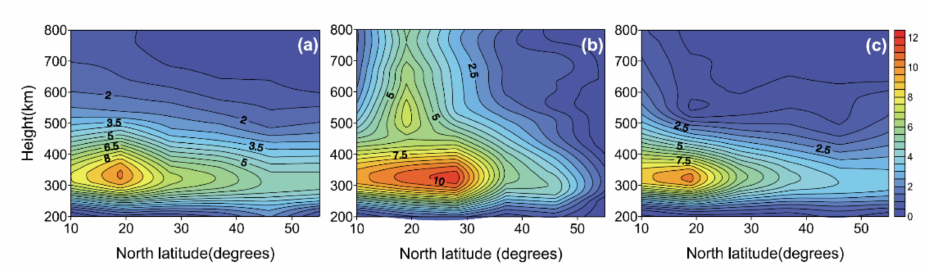
Figure 12. Two-dimensional images of IED at 21 LT on magnetic quiet days ( a , c ) and on the magnetic storm day ( b ) (from [13]). ( a ) 17 August 2003, ( b ) 18 August 2003, and ( c ) 19 August 2003. The unit of electron density is 10 11 e/m 3